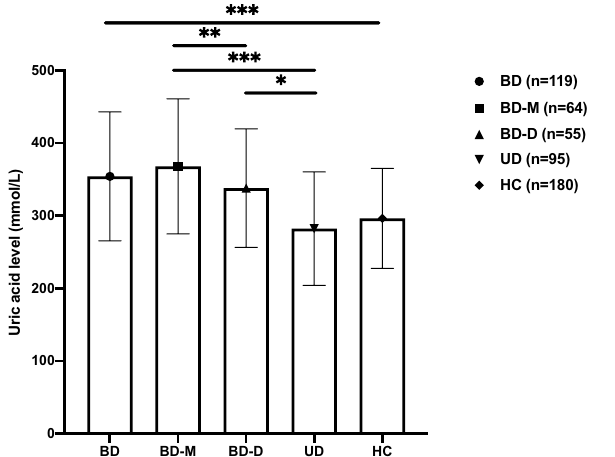
Figure 1. UA levels of participants in acute stage. UA of BD group was higher than UD and HC groups, while the difference between UD group and HC group was not significant. UA of BD-M subgroup was higher than BD-D subgroup and UD group, and UA of BD-D subgroup level was higher than UD group. BD, bipolar disorder; BD-M, mania/hypomania; BD-D, bipolar depression; UD, unipolar depression; HC, healthy control; UA, uric acid. *P < 0.050; **P < 0.010; ***P < 0.001.